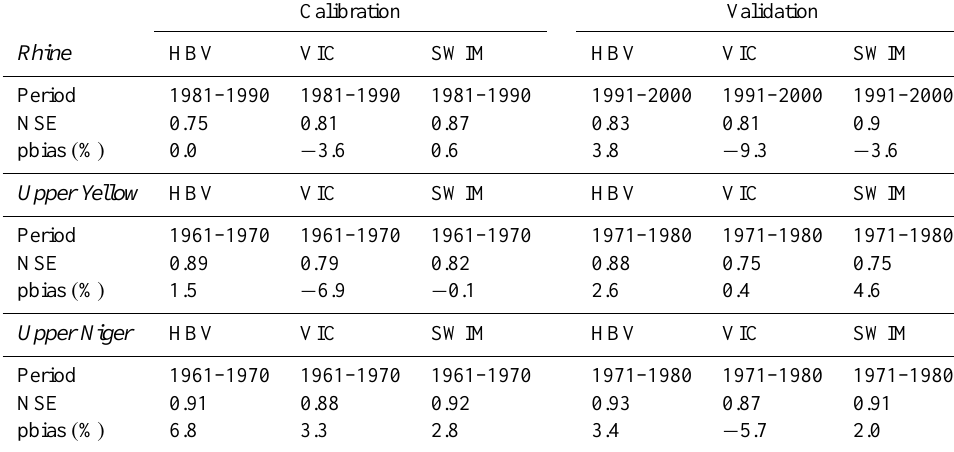
Table 3. Calibration and validation results with the daily time step. NSE = Nash and Sutcliffe efficiency; pbias = percent bias.